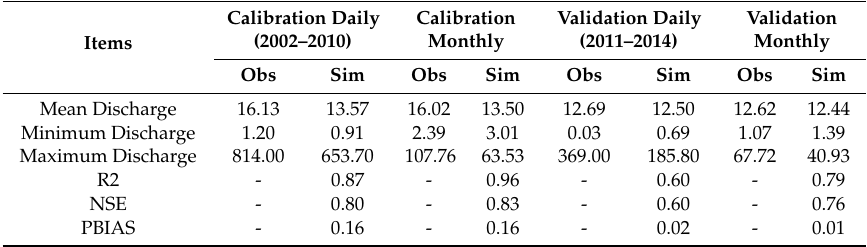
Table 3. Statistical indicator performance of daily and monthly